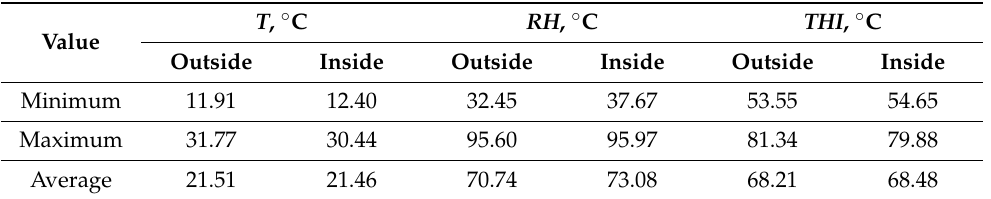
Table 2. Maximal, minimal, and average values (indicators) of the temperature ( T ), relative humidity ( RH ), and temperature humidity index ( THI ) of the air.